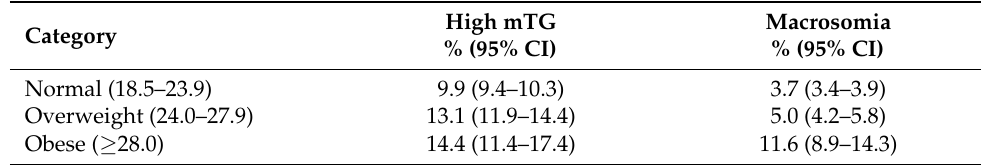
Table 2. The prevalence of high mTG levels and fetal macrosomia across maternal pre-pregnancy BMI